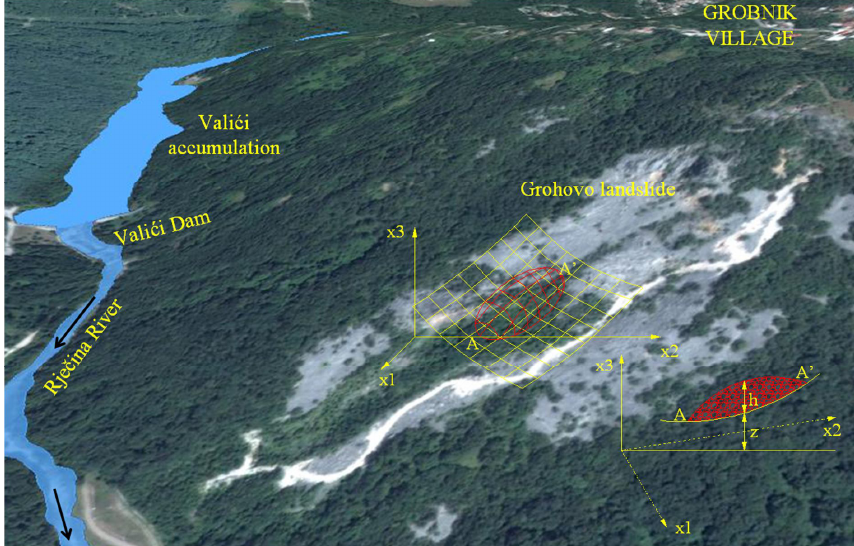
Figure 7. Reference system and notation used in the numerical